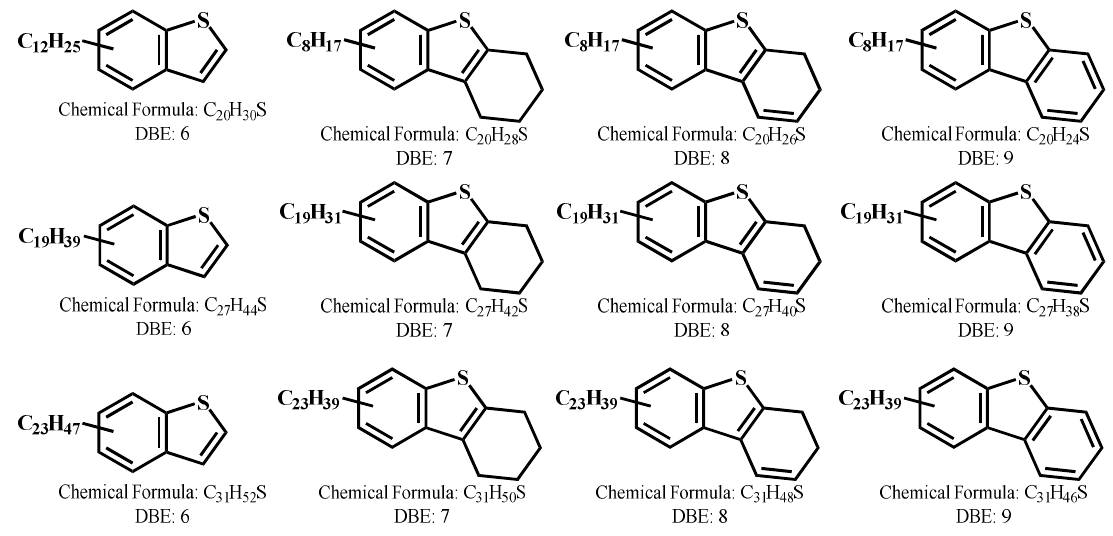
Figure 8. Suggested structures for some of the assignments of an S class for APPI( + ) measurements of saturates from Arabic medium oil. The presented assignments are three of the most abundant peaks in the APPI( + ) spectrum from DBE 6, and their related higher DBE assignments with the same carbon atom numbers in their chemical formula.